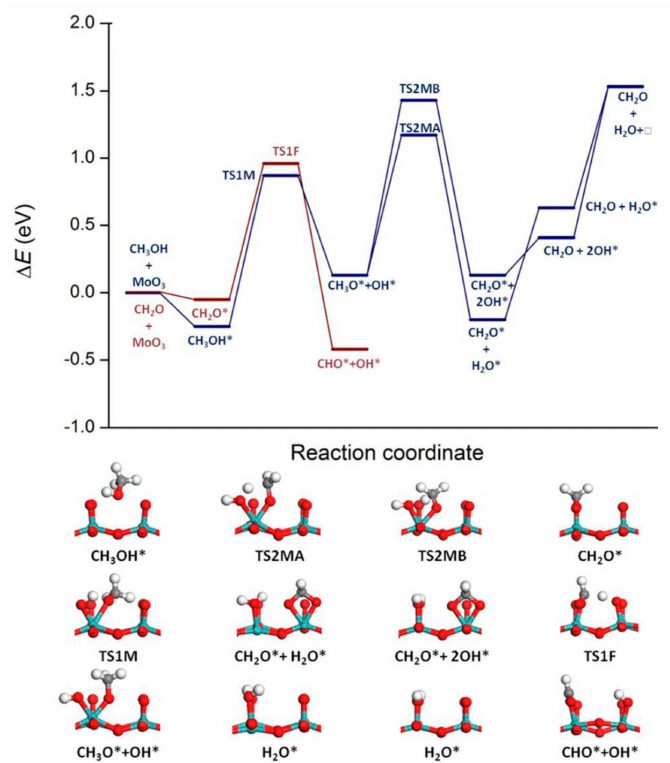
Figure 10. Reaction energy profile calculated by DFT for the oxidation of MeOH to FA via two different routes (blue lines) and FA decomposition (red line) on a α -MoO 3 (010) surface. Newly formed vacancies are marked by (cid:3) . Beneath the reaction energy profile, the structures for the different reaction coordinates are shown, where TS1F means that it was transition state 1 starting from FA, and TS1M was transition state 1 starting from methanol. For the structures, the colors are as follows: red: O; cyan: Mo; dark grey: C; white: H. © 2015 Wiley-VCH Verlag GmbH & Co. KGaA, Weinheim